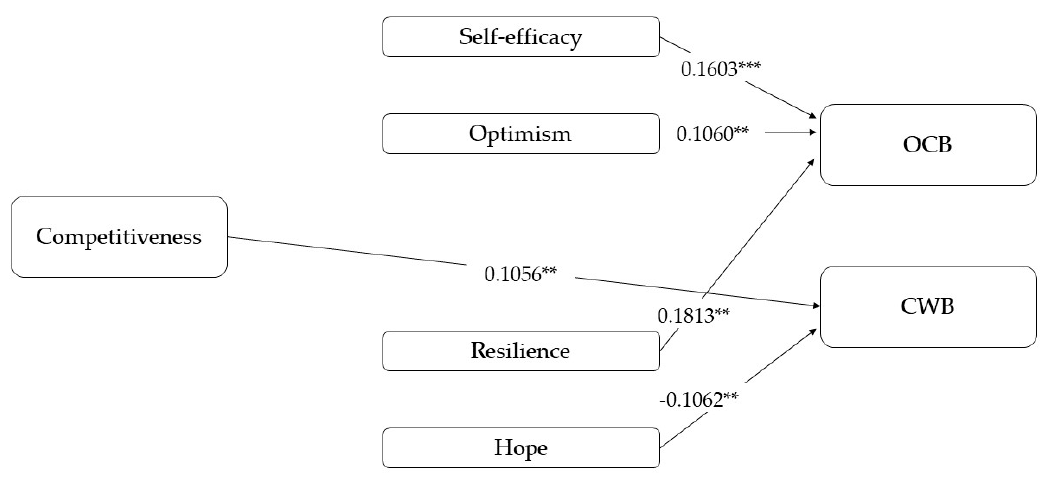
Figure 4. Results of the mediation models with other-referenced goals as an independent variable.